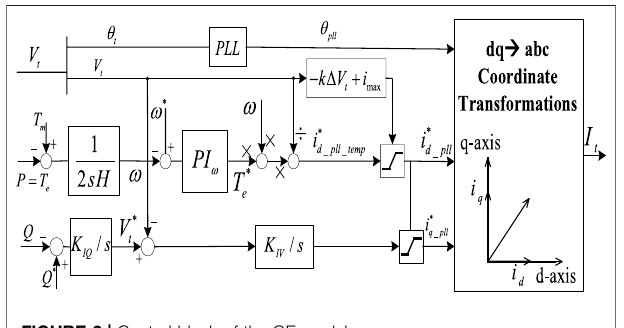
FIGURE 2 | Control block of the GE model.